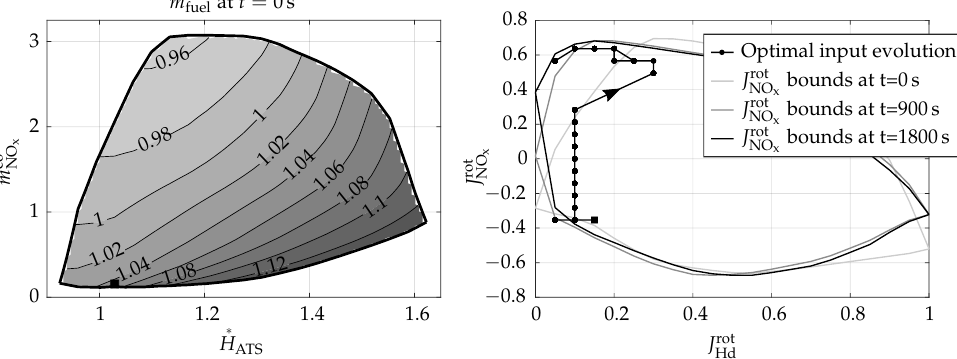
Figure 11. The left plot shows the Pareto front at the initial ATS temperature for the Conv VEC case on the simplified driving mission. The square marker shows the operation selected by the optimization. The right plot shows the evolution of the optimal engine strategy inputs and their bounds. All values were